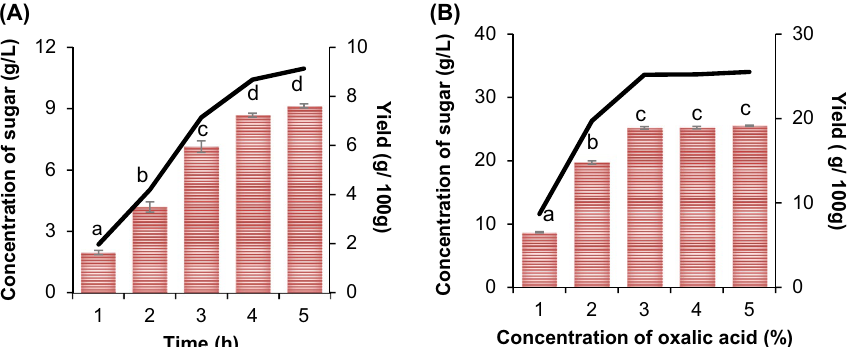
Figure 1. The effect of ( A ) residence time (1–5 hs) and ( B ) concentration of oxalic acid (1–5%). Note: a–d represent a grouping information through Tukey’s Method at 95% confidence. Means that do not share a same letter are significantly different; data presented are calculated as means ± standard deviations of triplicate